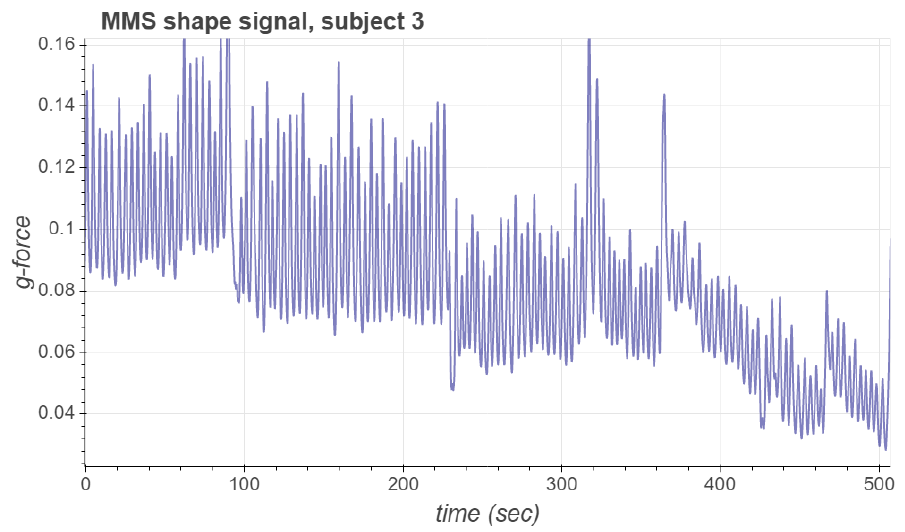
Figure 3. MMS shape signal for subject 3. Table 2. Parameters used for computing the MMS respiration signal results presented in this work. Algorithm